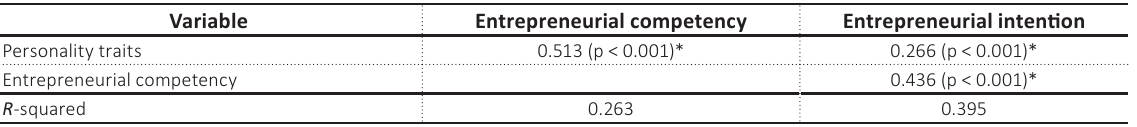
Table 5. Path coefficient and R